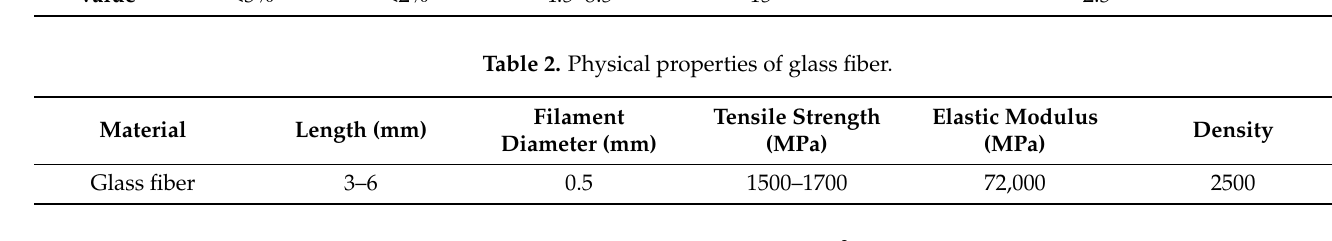
Table 3. Mix composition (Kg/m 3